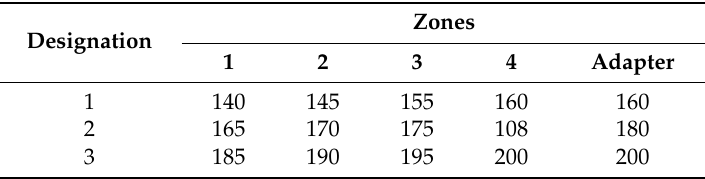
Table 5. Temperature profiles of the single-screw extruder used for side dosing of the PP (temperature values are shown in ◦